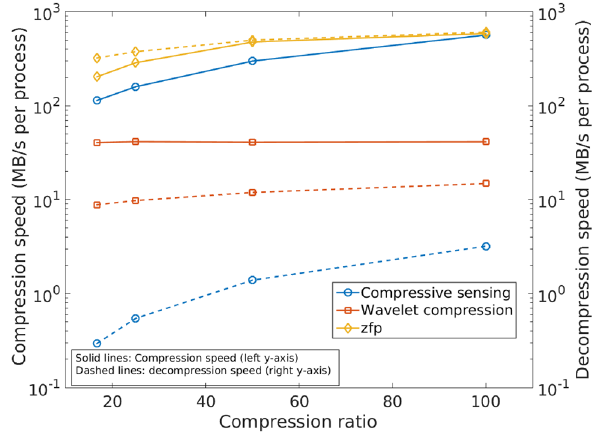
Fig. 16 Plots showing the compression and decompression speeds of different scientific data compression methods as a function of the compression ratio. A constant compression ratio was used throughout the subdomains. Results are reported from a RCCI simulation at t ¼ 72. Results are reported from a RCCI simulation at t ¼ 72 where N ¼ 25 ; 600. A wavelet order w ¼ 5 was used in compressed sensing and wavelet